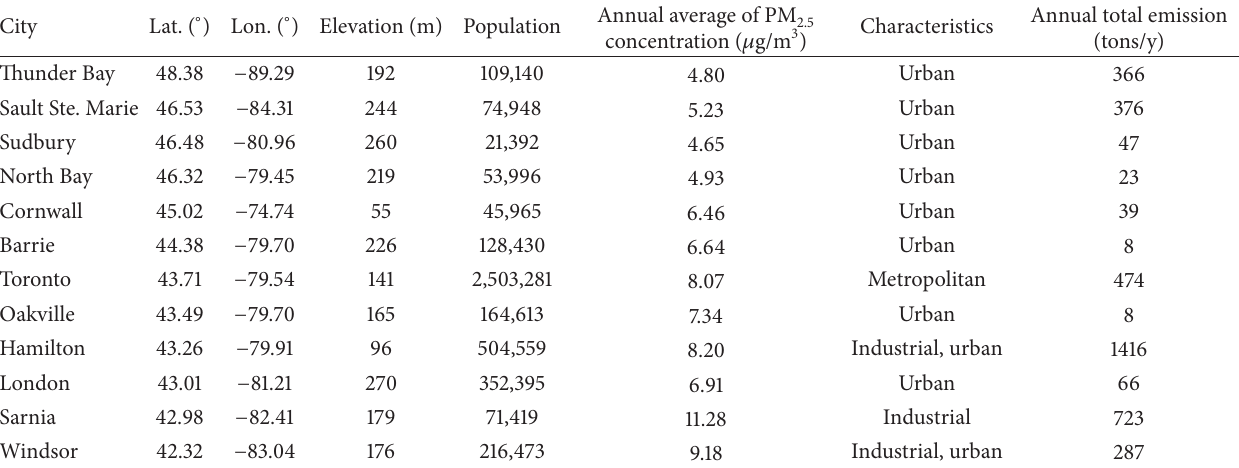
Table 1: Characteristics for the 12 Ontarian cities in 2006. The cities are ordered by descending latitude see Figure 1(a). City Lat. ( ∘ ) Lon. ( ∘ ) Elevation (m) Population